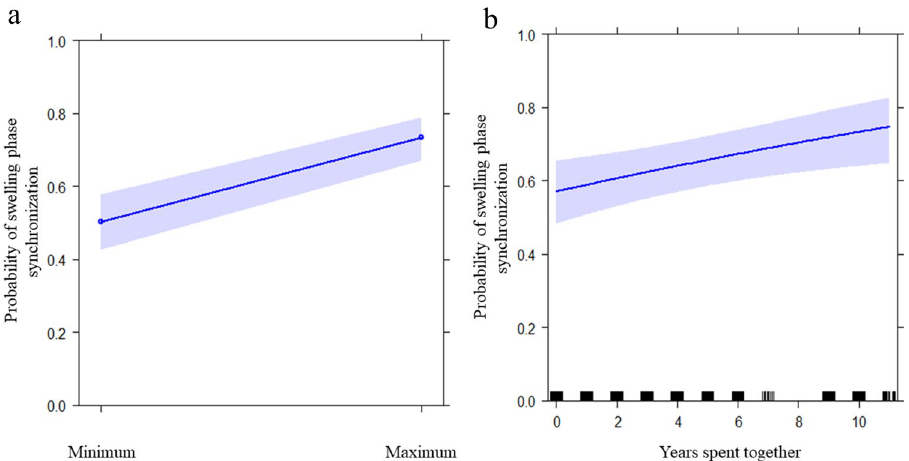
Figure 2. Effect plot of the variables having a significant influence on the swelling synchronization in GLMM 1 ( a,b ; Table 2). ( a ) The probability of swelling phase synchronization (Y axis) was higher in maximum swelling phase (MSP) than in the minimum swelling phase (X axis); ( b ) the probability of swelling phase synchronization (Y axis) increased as the number of years spent together increased (X axis).